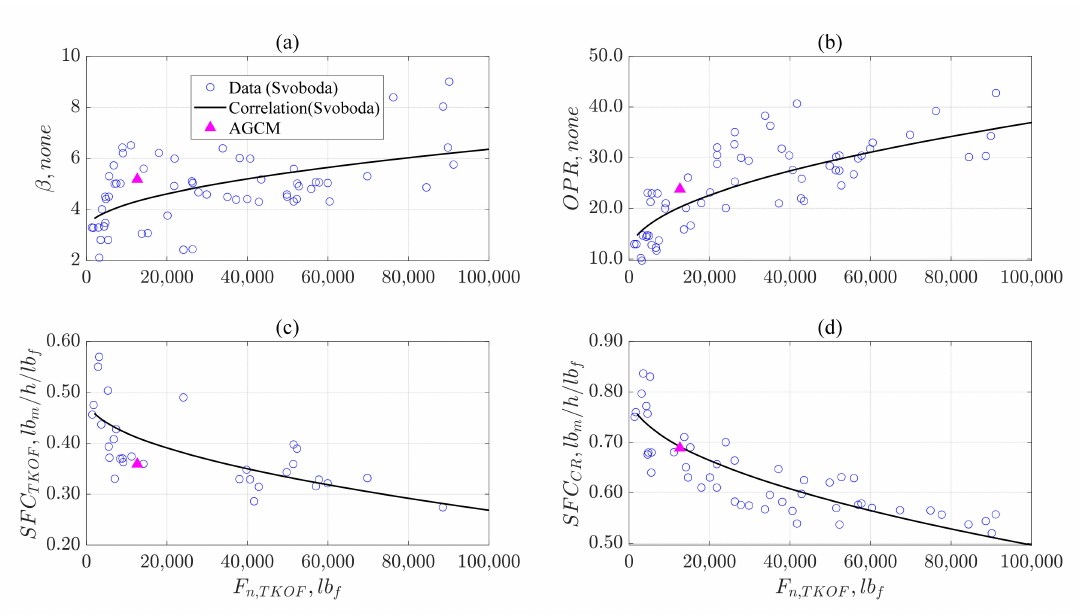
Figure 8. Performance comparison, Aerothermodynamic Generic Cycle Model (AGCM) vs. [22]. ( a ) β vs. F n,TKOF , ( b ) OPR vs. F n,TKOF , ( c ) SFC TKOF vs. F n,TKOF , ( d ) SFC CR vs. F n,TKOF